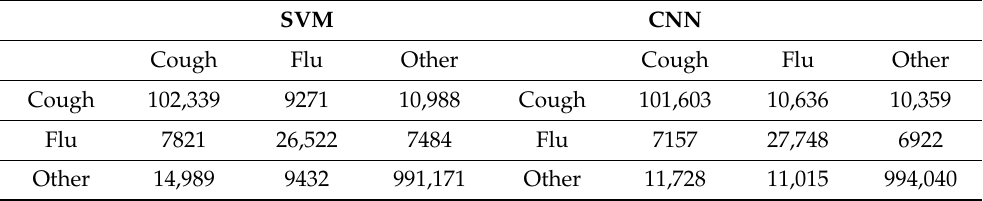
Table 5. Confusion matrix for “Cough” and “Flu syndrome” pathways using 2017–2018 models. SVM CNN Cough Flu Other Cough Flu Other Cough 102,339